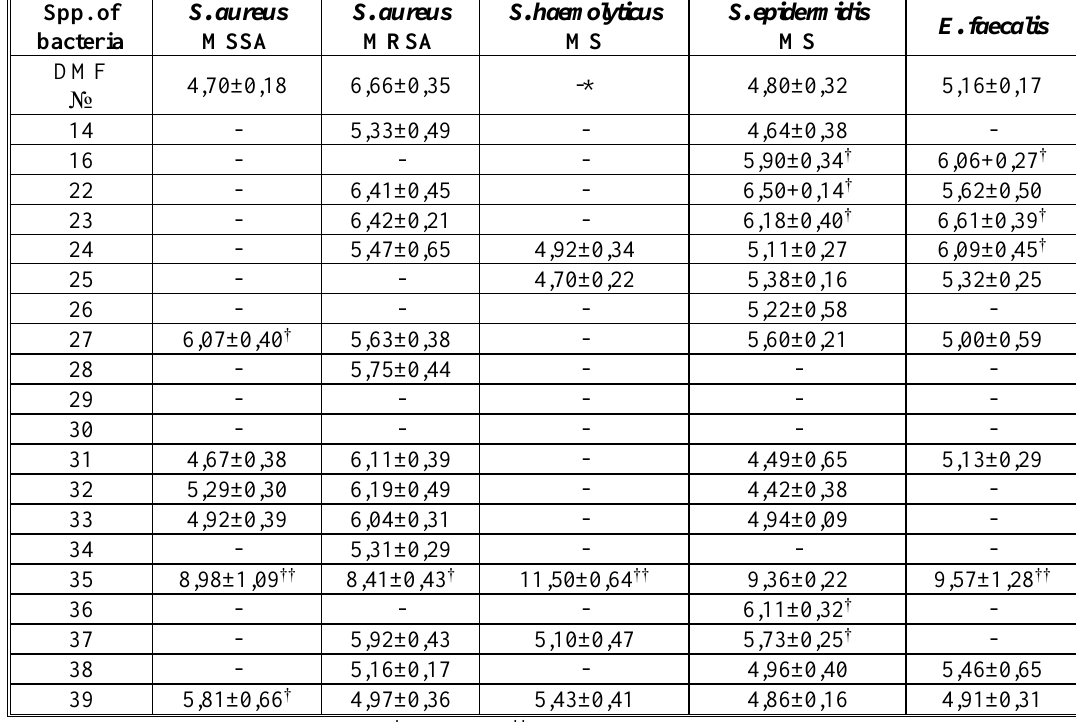
Table 2. Antimicrobial effect of synthesized compounds on Gram-positive bacteria. Spp.